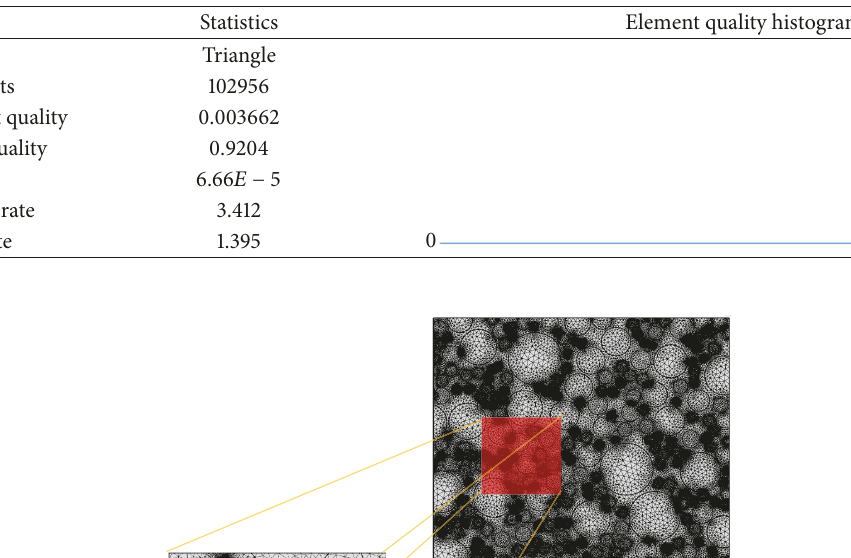
Table 3: Statistics of the elements.